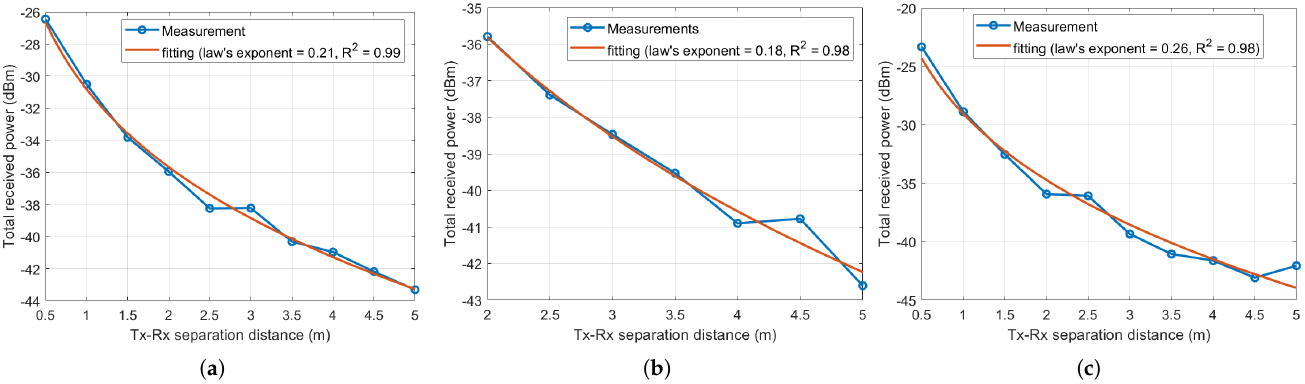
Figure 7. Total measured received power with Tx-Rx separation distance in ( a ) the Manufacturing hall at Dokka Fastners AS, ( b ) the Test room at Dokka Fastners AS, and ( c ) NTNU